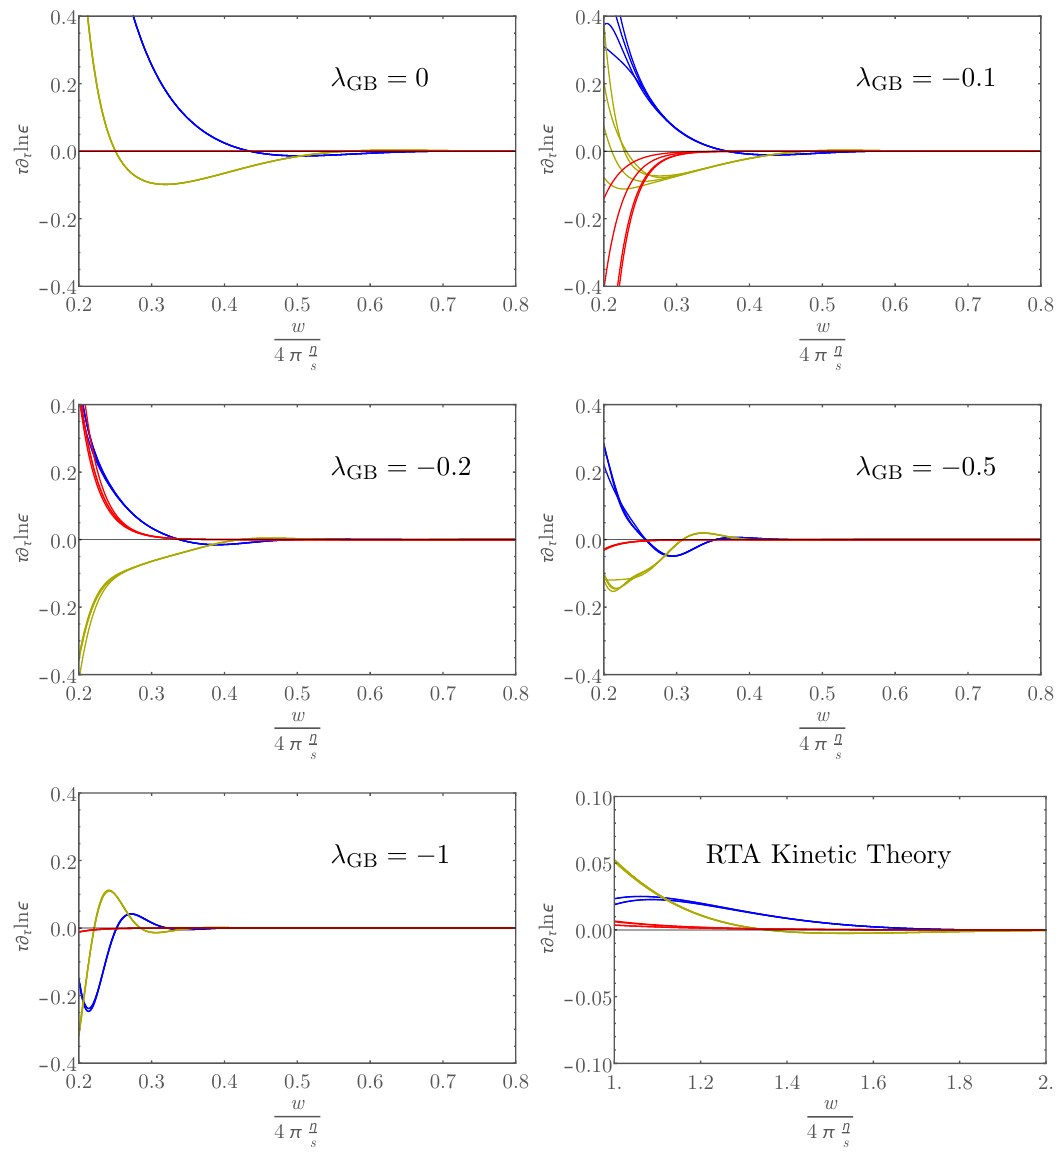
Figure 5 . Non-hydrodynamic modes Re[ D c ] (blue), Im[ D c ] (yellow) and D (cid:6) (red) as described in Equation (4.2) for di(cid:11)erent couplings. Each curve in (cid:12)gure 5 has been made by varying the Pad(cid:19)e order N over the four previous values, with the exception of the (cid:21) GB = 0 case where N is chosen to take values of 80, 90, 120 and 190. The visible deviations are intended to give a sense of the convergence of the Pad(cid:19)e Approximant and so the convergence of these non-hydrodynamic modes.